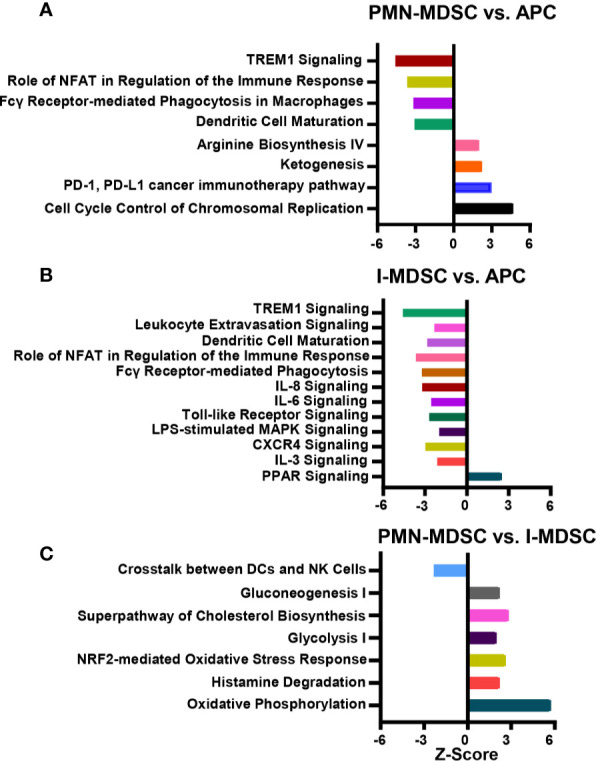
Canonical and signaling pathway analyses of myeloid subpopulations in the CRC tumor microenvironment. Functional categorization of top significantly upregulated and downregulated transcripts (with a fold change > 2, P value cutoff < 0.05) from CLC analysis were analyzed through IPA. Top significantly affected (1.5 > Z score < -2.0) canonical pathways were analyzed by IPA. The horizontal bars denote the different pathways based on the Z-scores; PMN-MDSC vs. APC (A), I-MDSC vs. APC (B) and PMN-MDSC vs. I-MDSC (C).